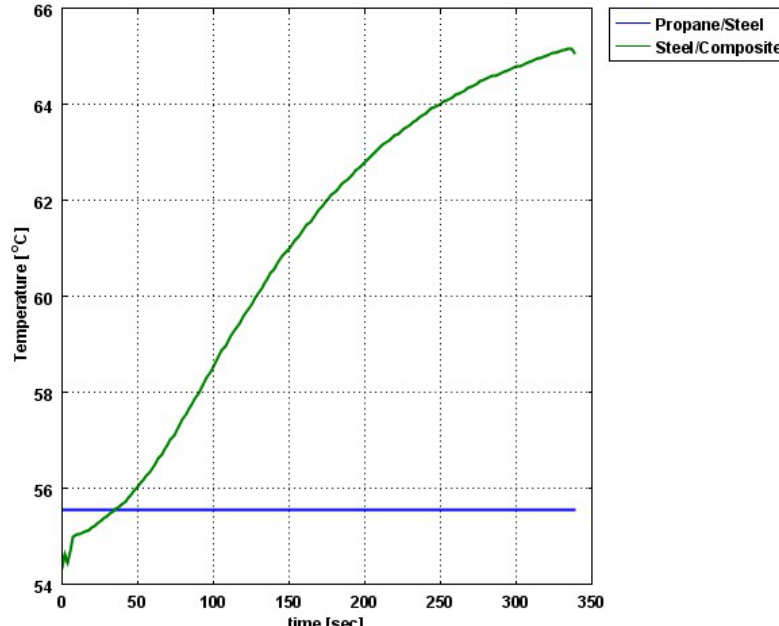
Figure 13. Calculated temperatures at the interface of glass-woven vinyl ester/steel and at the Propane/Steel interface.